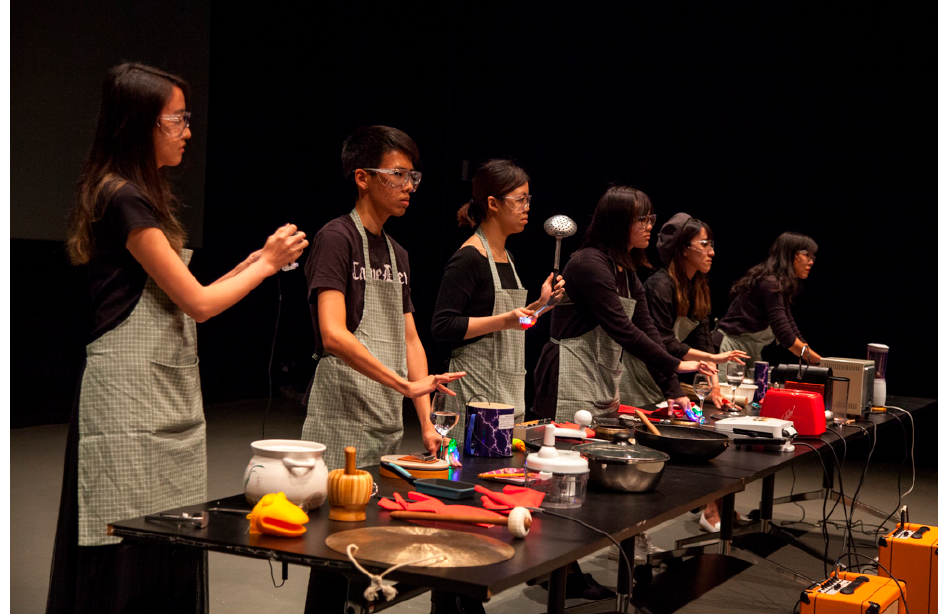
Figure 3. Participants of the 22 nd International Symposium on Electronic Art. ISEA2016 Hong Kong 香港 Cultural R>evolution . Public Kitchen. School of Creative Media, City University of Hong Kong, China,